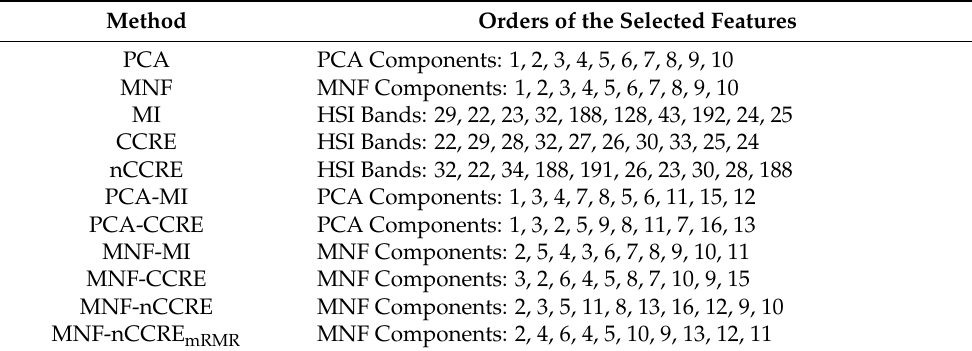
Table 3. The order of selected features for AVIRIS IP dataset. Method